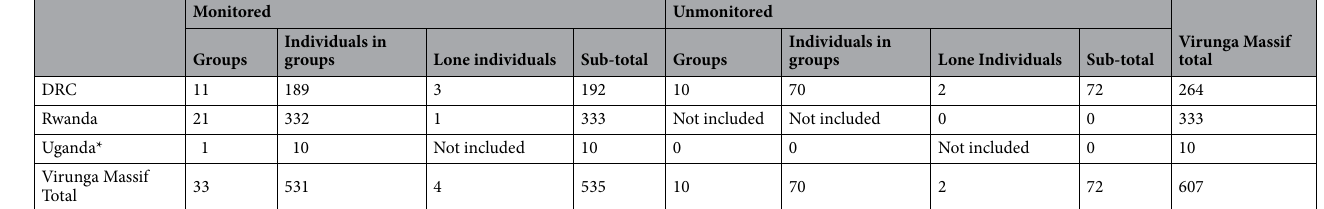
Table 3. Number of monitored and unmonitored Virunga Massif mountain gorillas in the DRC, Rwanda, and Uganda included in the Outbreak model, based on group sizes observed at the end of 2018. *Because only one group was located in Uganda, and was a group that sometimes came into Rwanda, we combined the Rwanda and Uganda groups into one dataset (RW-UG).